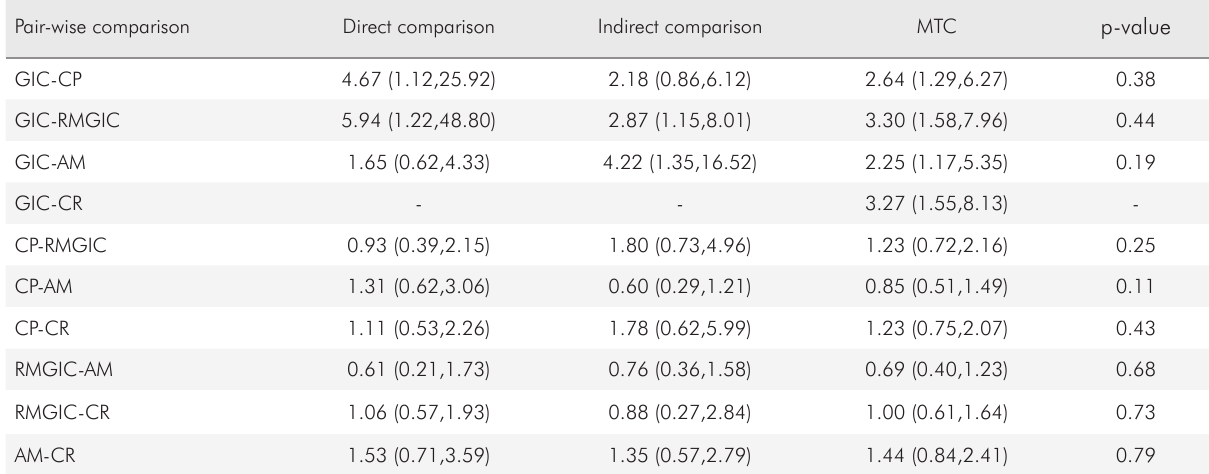
Table 3. Mixed treatment comparison (MTC) model comparing all the direct restorative materials used in primary teeth. Pair-wise comparison